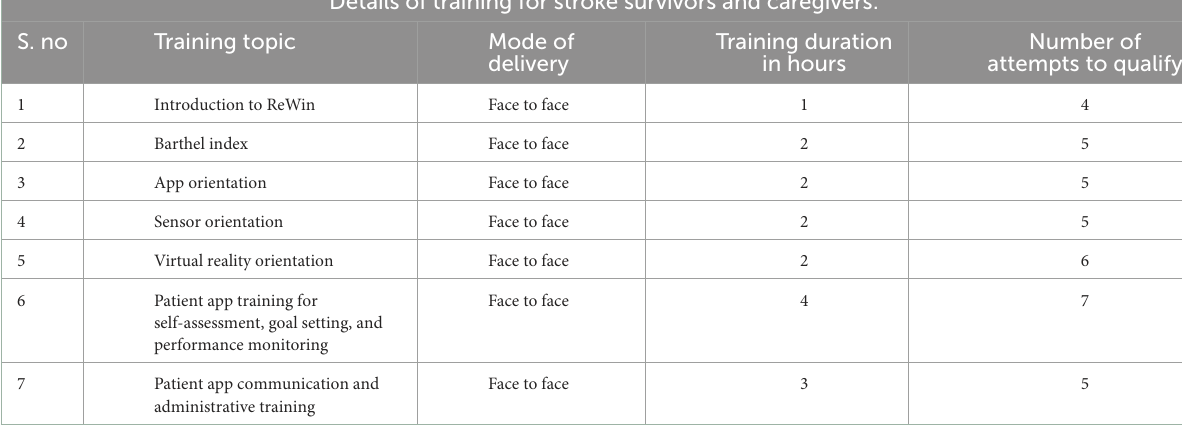
TABLE 2 Details of training for stroke survivors and caregivers. Details of training for stroke survivors and